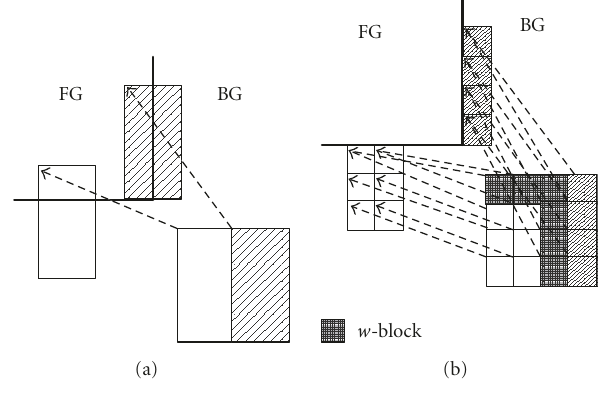
Figure 10: Illustration of motion vector remapping. (a) Original coding mode and motion vectors. (b) Using Inter 4 × 4 mode and refined motion